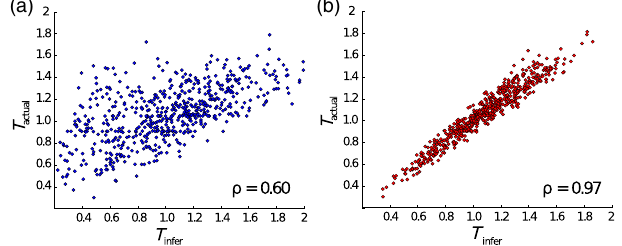
FIG. 3. Validation of VMSI for force inference using synthetic data. (a) Comparison of actual and inferred tensions based on the matrix-inverse-type inference method introduced in Ref. [29] made overdetermined using measured edge curvature data, as in Ref. [35]. 10% noise was added to the synthetic input data (see Appendix D for details). ρ denotes Pearson ’ s correlation coef- ficient. (b) Same as (a) but using the VMSI on the same synthetic data. Note the significant increase of the correlation